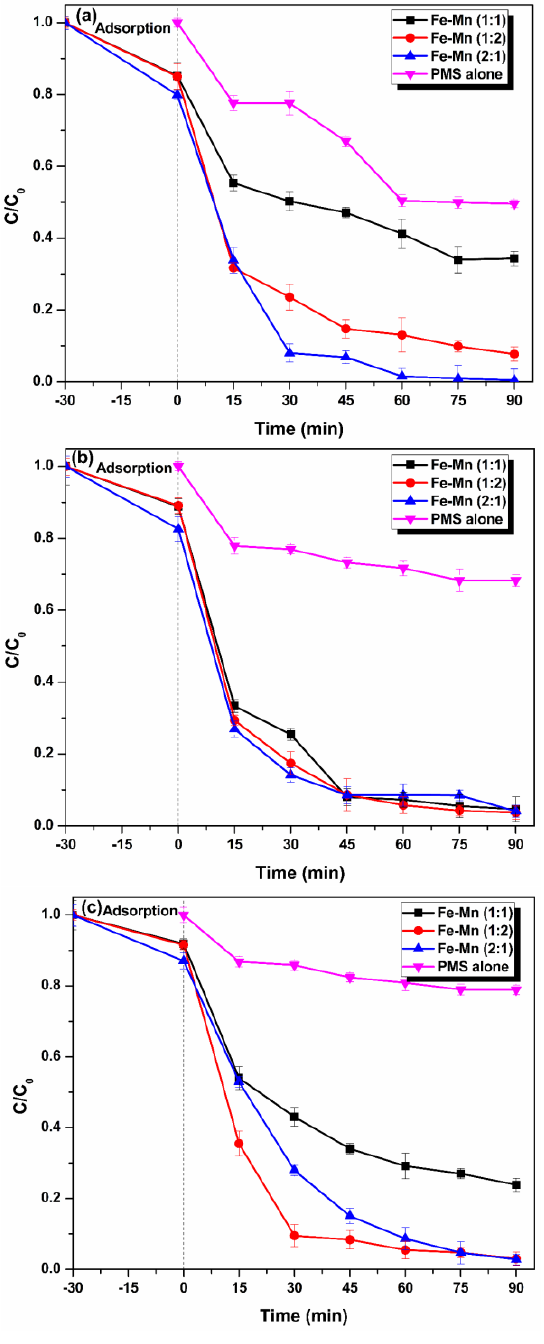
Figure 4. RhB degradation by the bimetallic oxides (100 mg/L) at different pH conditions: ( a ) pH 3; ( b ) pH 7; and ( c ) pH 10 using 0.25 mM